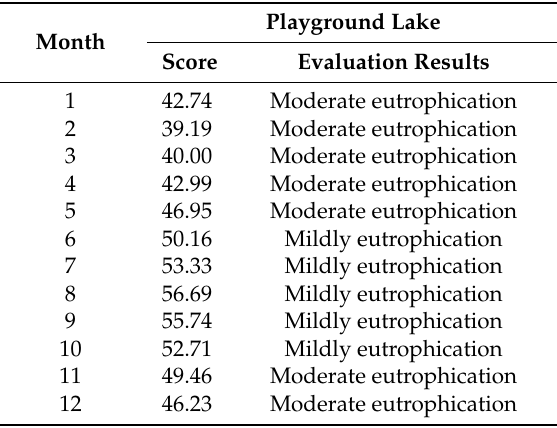
Table 7. Predicted results of eutrophication.